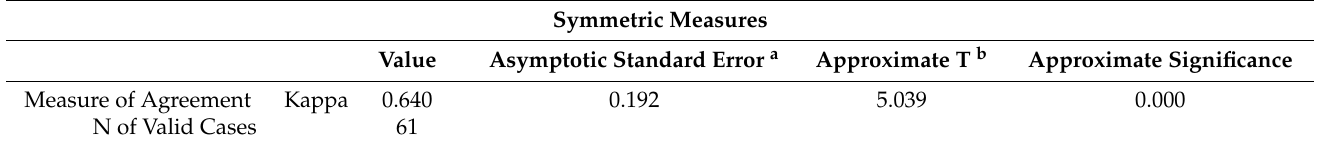
Table 2. Agreement full-text screening percentage and kappa result between first and second reviewer.